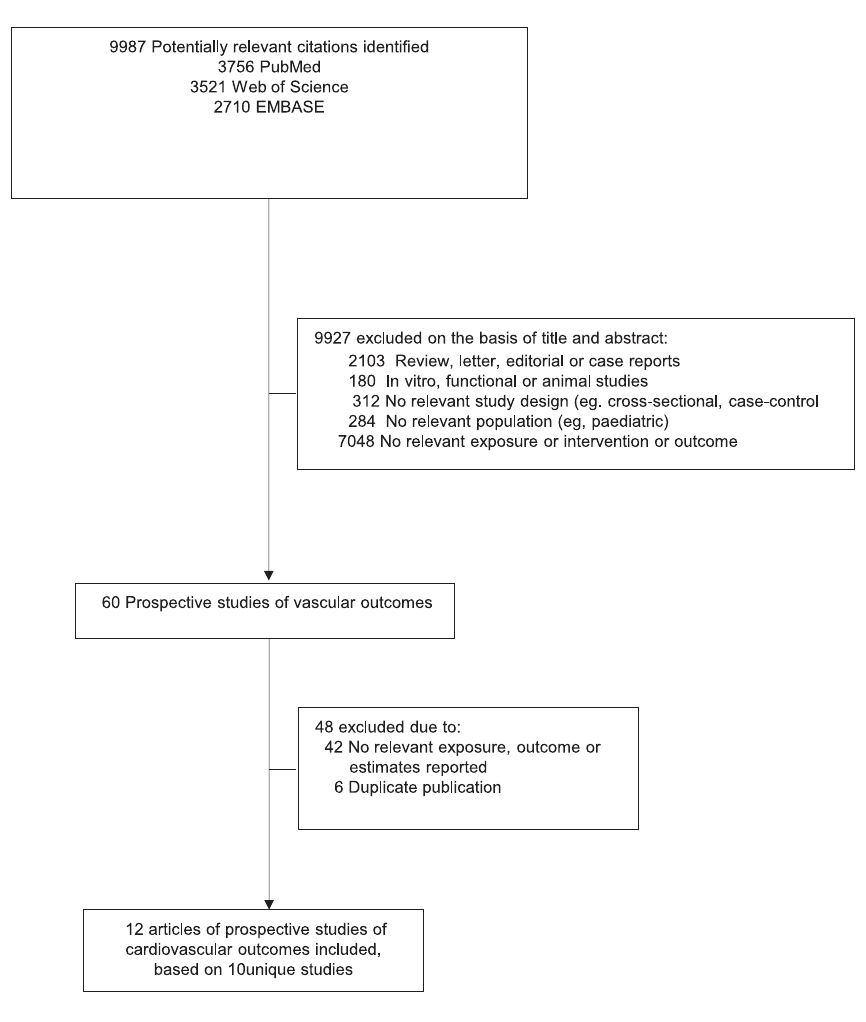
Fig 1. Flow diagram of studies included in the current